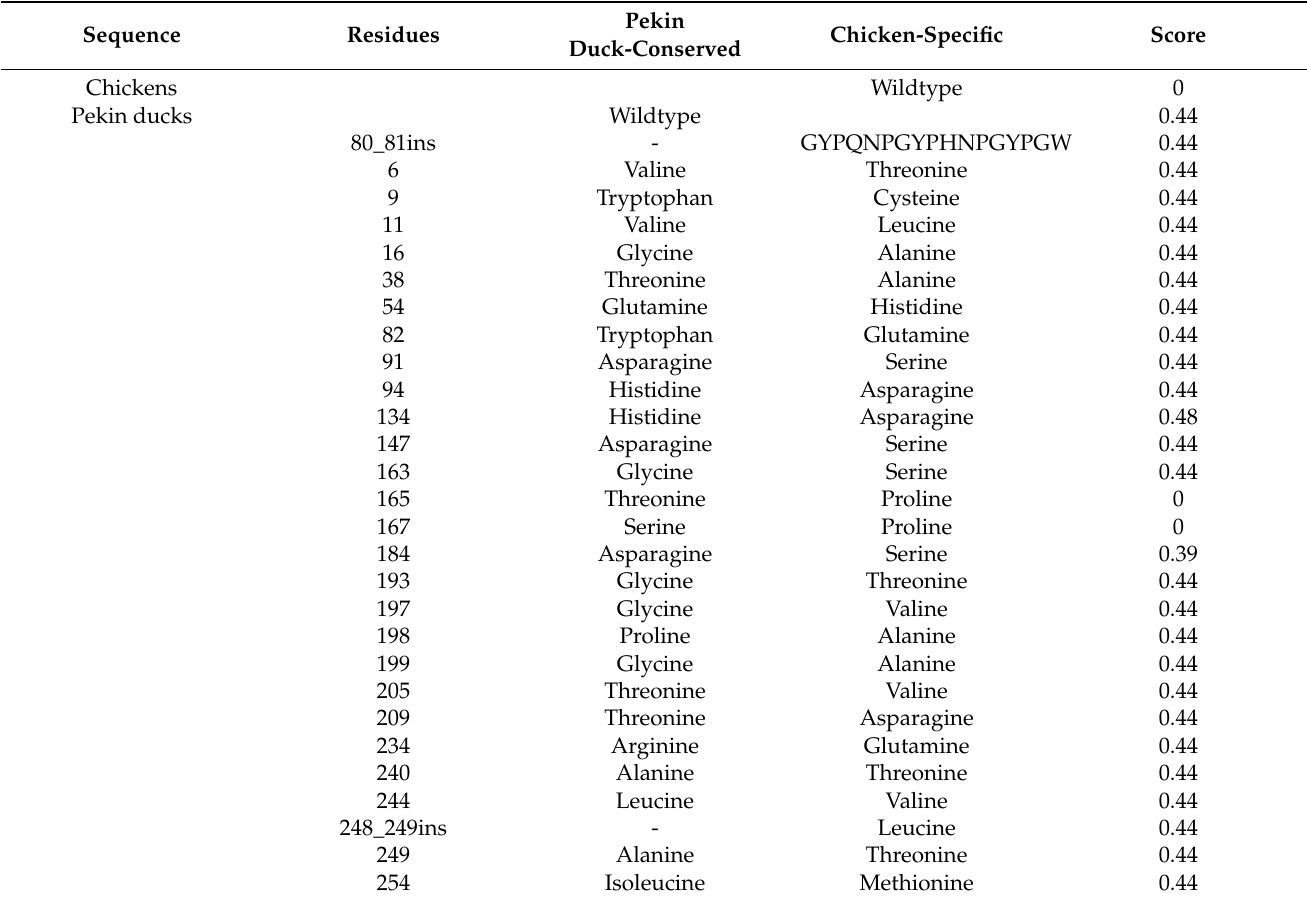
Table 2. Prediction of the aggregation propensities in the Pekin duck prion protein (PrP) with substitutions of different residues compared with the chicken